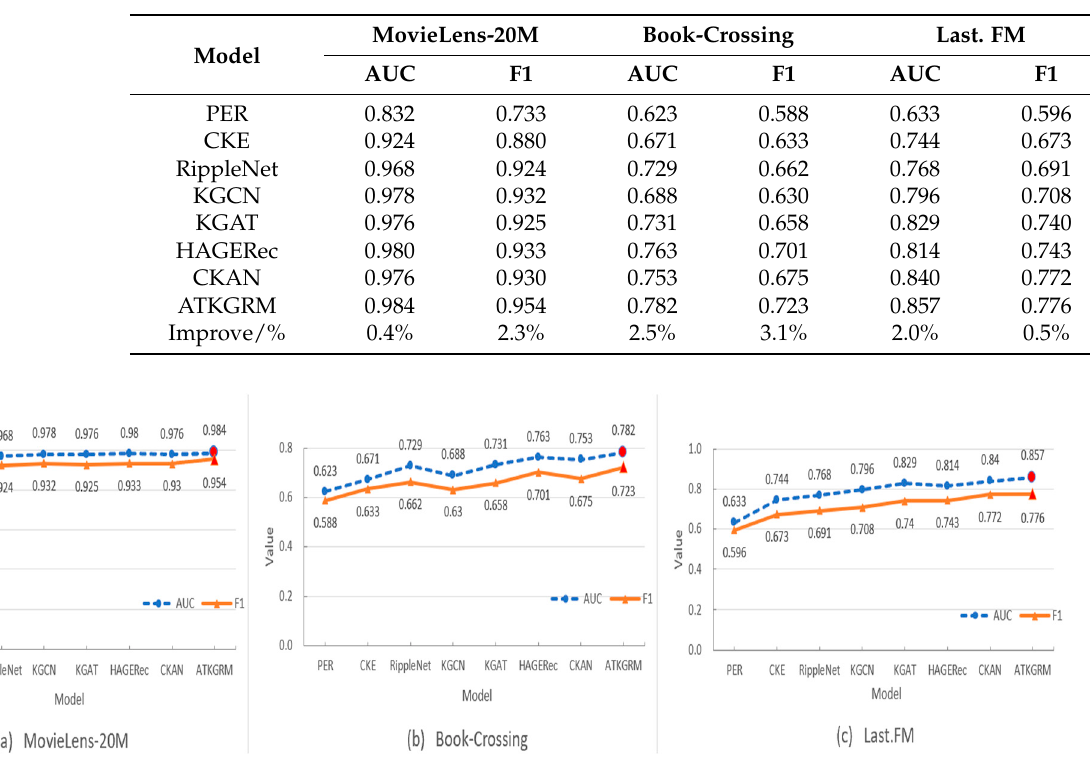
Figure 3. Comparison results of knowledge graph recommendation models. (On three different datasets)